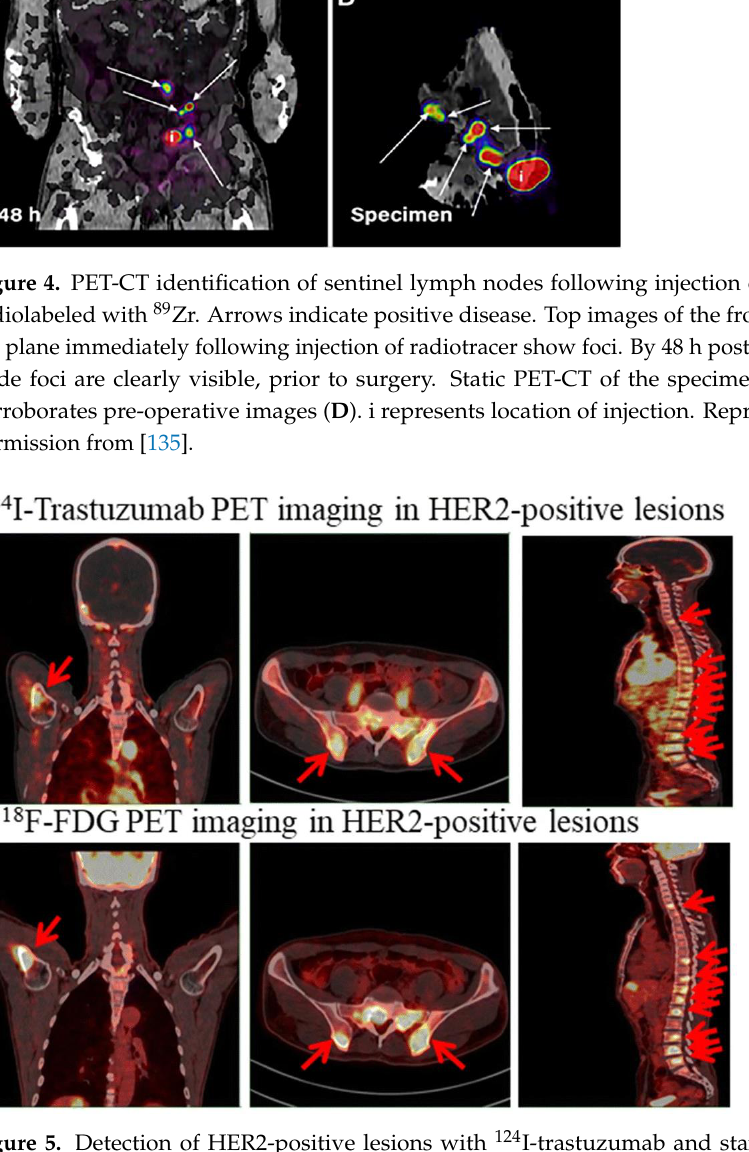
Figure 5. Detection of HER2-positive lesions with 124 I-trastuzumab and standard 18 F-FDG PET imaging in humeral, bilateral ilium, and spinal metastases. Arrows point to HER2-positive gastric cancer lesions. Reprinted/adapted with permission from Ref. [136].